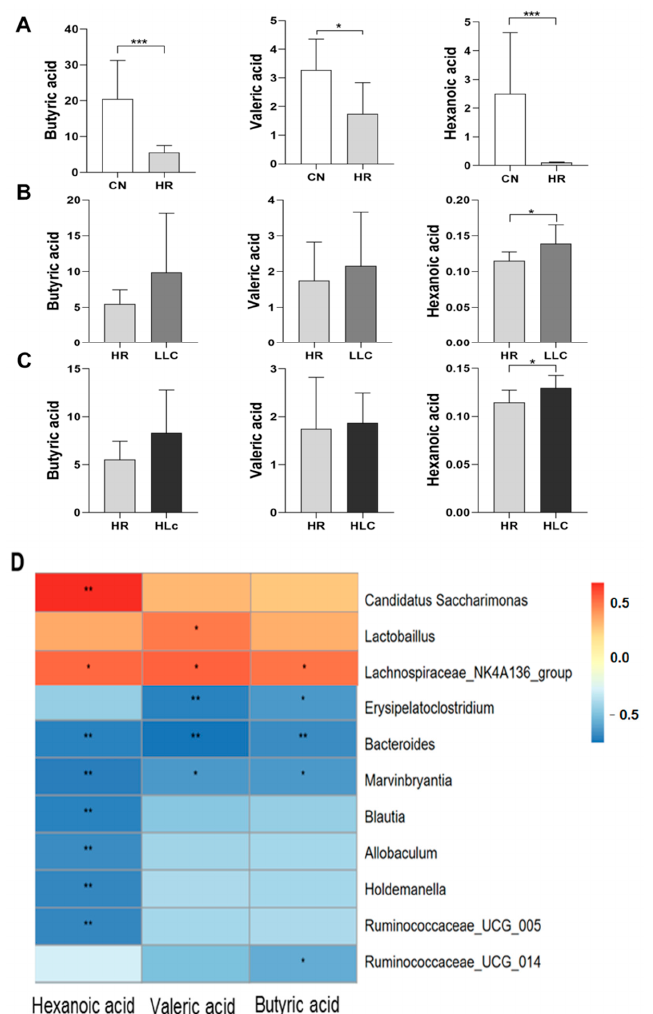
Figure 5. The Effects of Lactobacillus casei and Anti-TB drugs on fecal short-chain fatty acids at week 6. ( A )The effect of anti-TB drugs on short-chain fatty acids in rat feces. The effect of probiotics intervention on short-chain fatty acids in feces of rats with anti-TB drugs: ( B ) Low-dose L. casei ATCC334 , ( C ) High-dose L. casei ATCC334. ( D ) Spearman correlation analysis of short-chain fatty acids and intestinal microbes at the genus level. The top 20 genera in relative abundance were included in the analysis, the correlation coefficient threshold is set to 0.1, p < 0.05 was considered statistically significant. * indicates p < 0.05, ** indicates p < 0.01, *** indicates p < 0.001. n = 9 in each group in Short-chain fatty acid analysis. The principle of joint analysis of intestinal microbes and short-chain fatty acid content is to match the same rat and the same intervention time. The number of matched rats in the HLc group was 2 and 3 in the other groups. CN: control group, HR: isoniazid + rifampicin model group, LLc: HR + low dose L. casei ATCC334 group, HLc: HR + high dose L. casei ATCC334